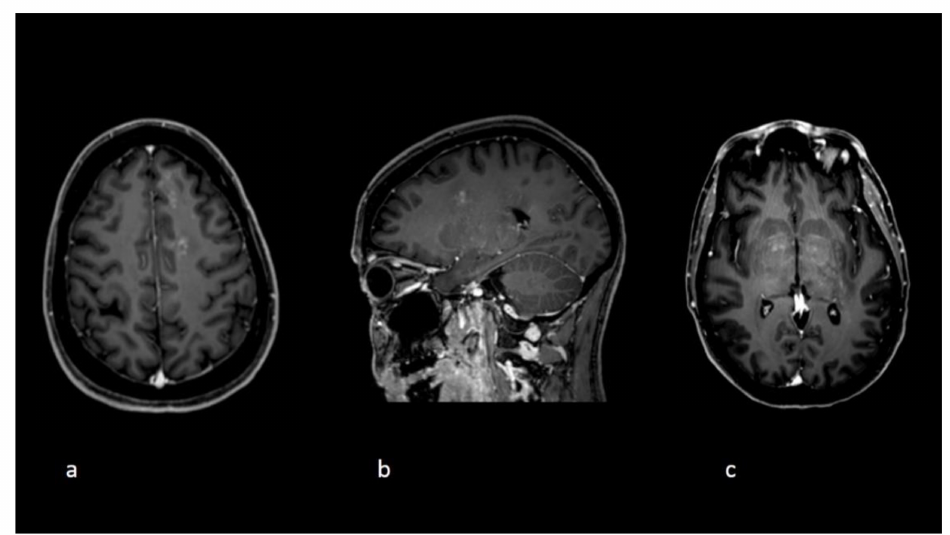
Figure 2. Follow-up imaging at the time clinical deterioration. Axial ( a , c ) and sagittal ( b ) T1 postgadoliniumimagesdemonstratenewwhitematterlesionswithapunctuatepatternofenhancements and an overall radiological pattern di ff erent compared to the initial